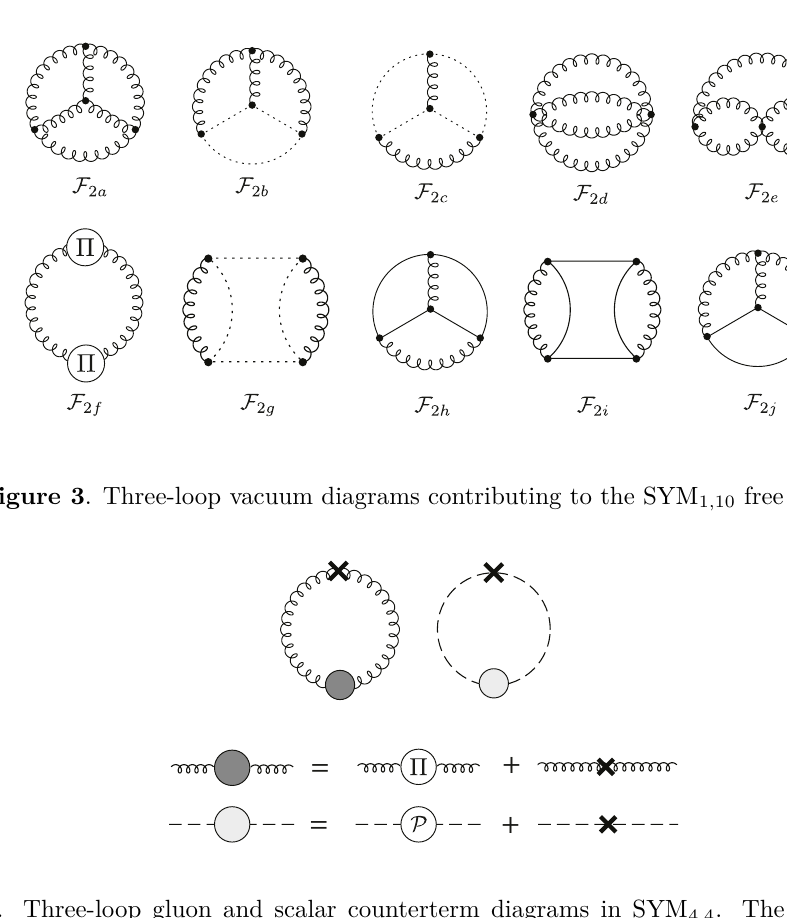
Figure 4 . Three-loop gluon and scalar counterterm diagrams in SYM 4 , 4 . The crosses are the “thermal counter-terms” arising from the last two terms of (3.7). Expressions for the SYM 4 , 4 gluon and scalar self-energies are presented in appendix